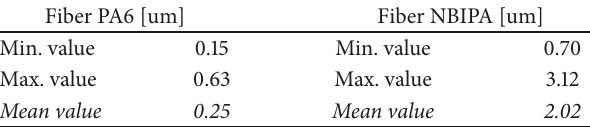
Table 2: Electrospinning characteristic of PA6 a NBIPA.